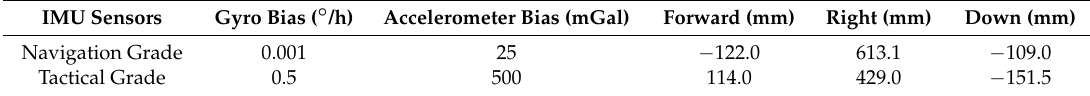
Table 1. Parameters of IMU sensors and lever-arm of receiver antenna with respect to IMU sensors.